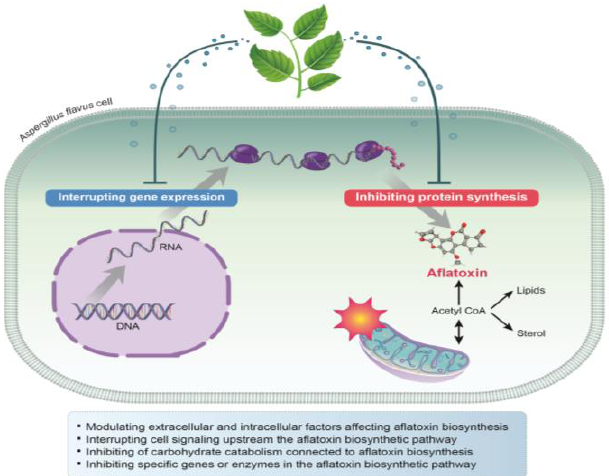
Figure 5. Mechanisms of action of plant-derived natural compounds against aflatoxin biosynthesis of A. flavus .